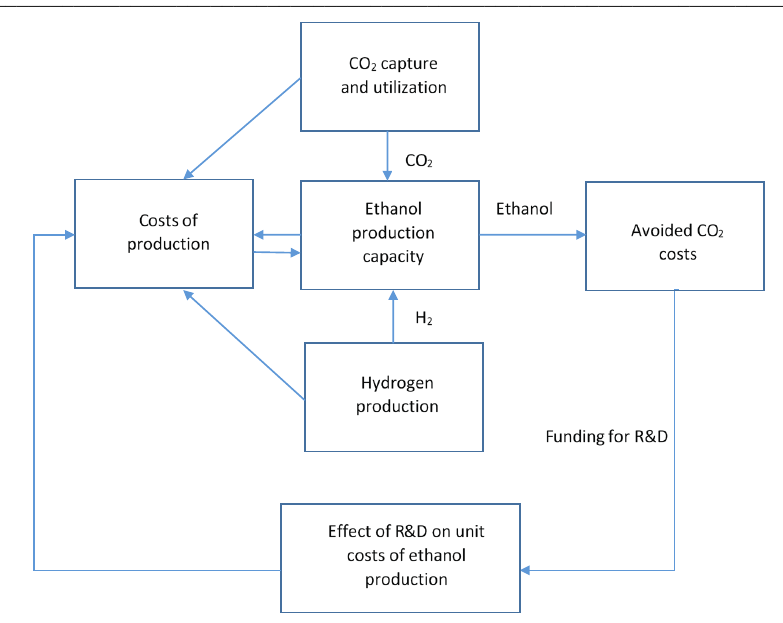
Fig. 2. Model structure, presenting the main